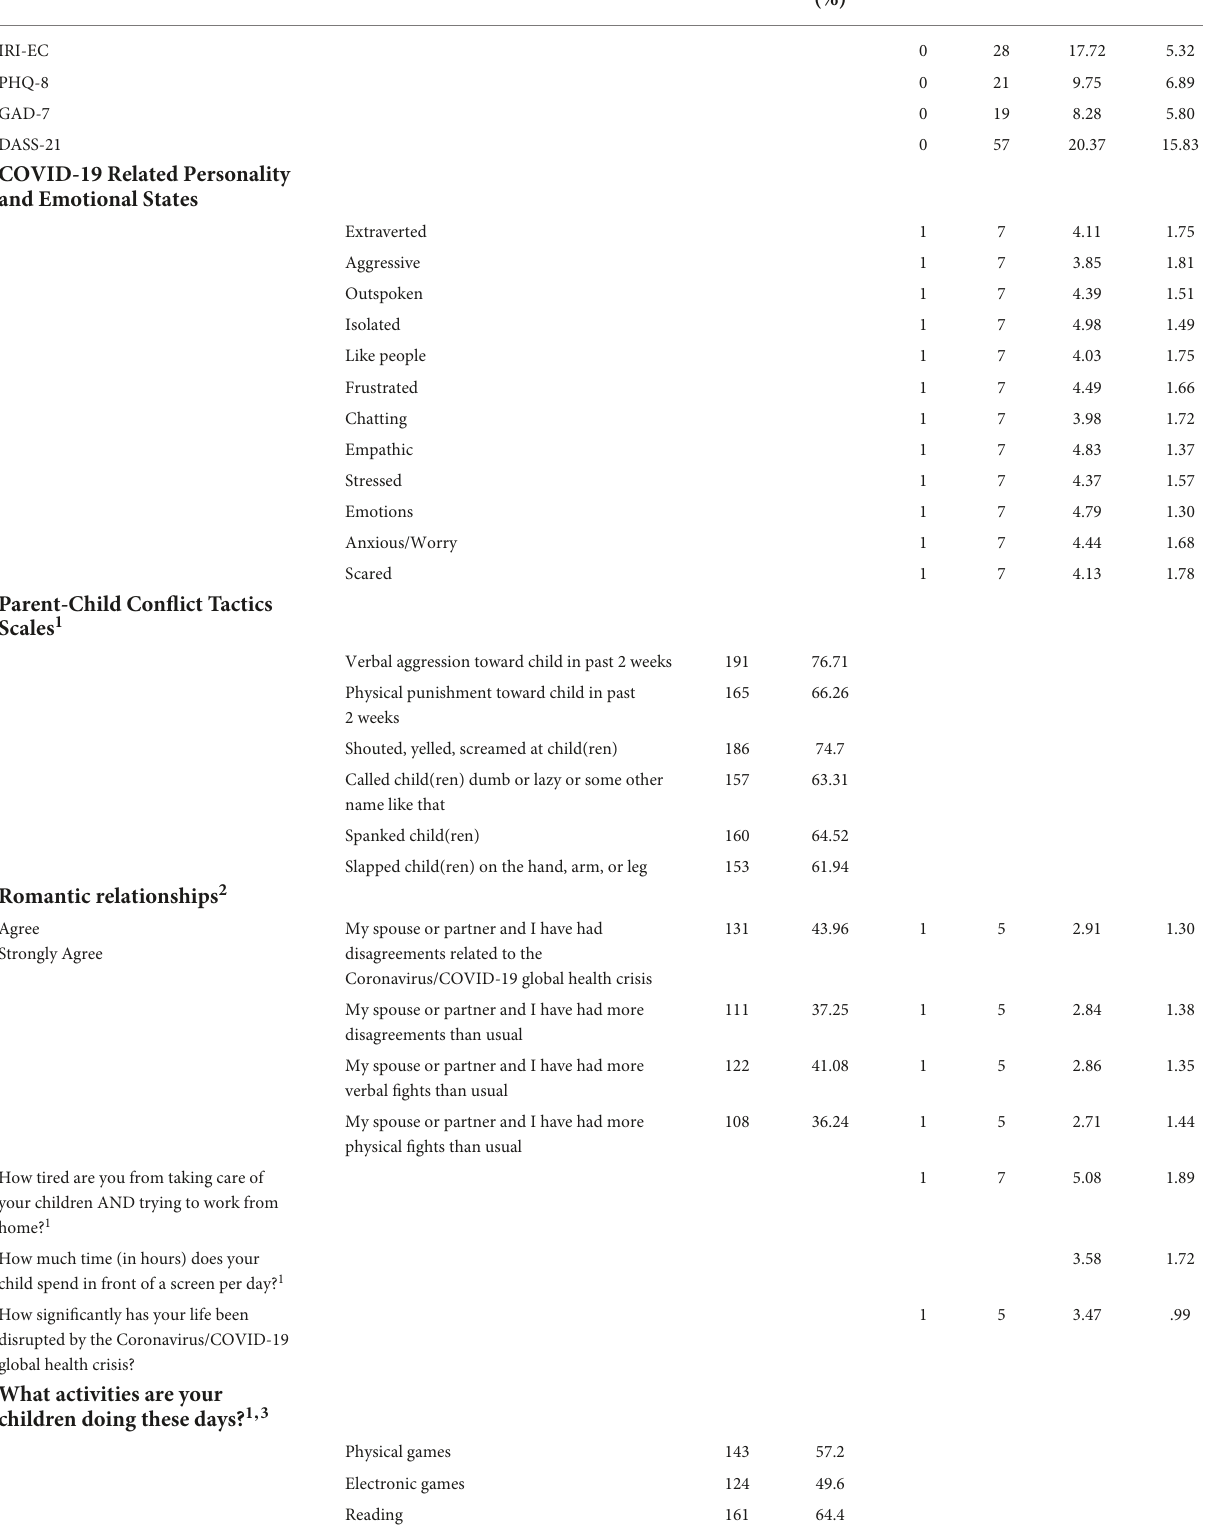
TABLE 1 Descriptive statistics of measures in the present